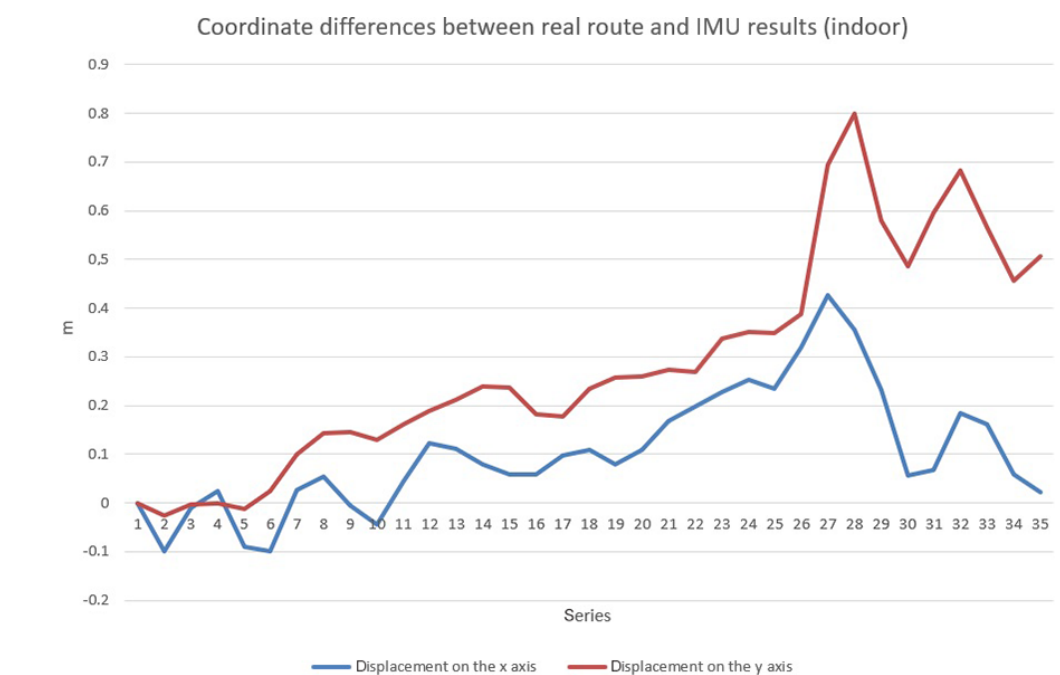
Figure 8. Coordinate differences between PDR IMU and real route results (indoor